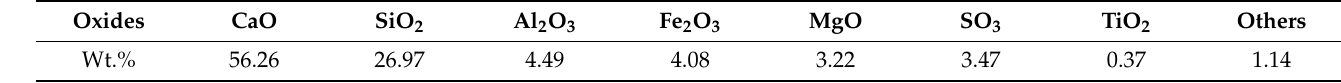
Table 3. The main chemical composition of